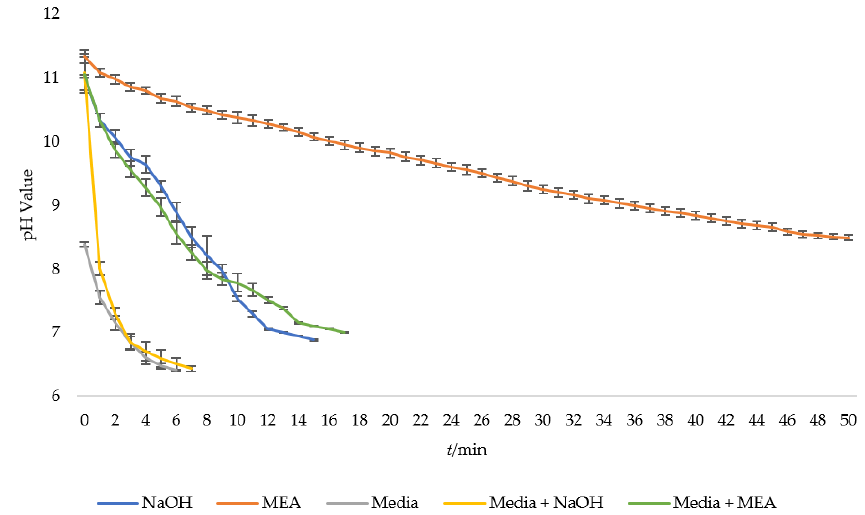
Figure 4. Effect of diffuser on pH change for five absorbents at p = 100 kPa, T = 20 °C, with an initial pH of 11 with exception of culture media with an initial pH of 8.5. pH of 11 with exception of culture media with an initial pH of